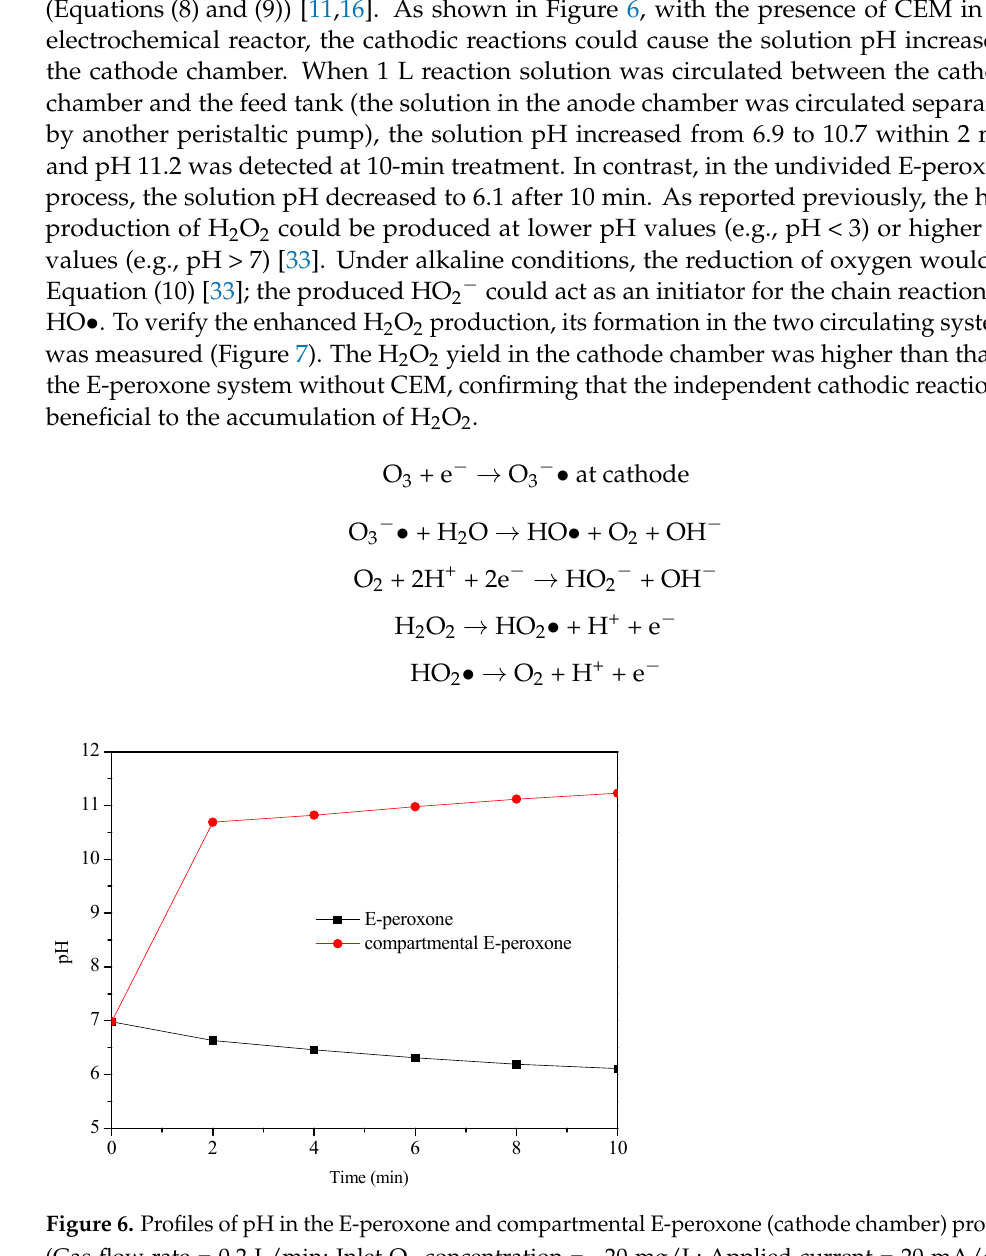
Figure 6. Profiles of pH in the E-peroxone and compartmental E-peroxone (cathode chamber) process. (Gas flow rate = 0.2 L/min; Inlet O 3 concentration = ~20 mg/L; Applied current = 20 mA/cm 2 ; Temperature = 25 ± 2 °C).